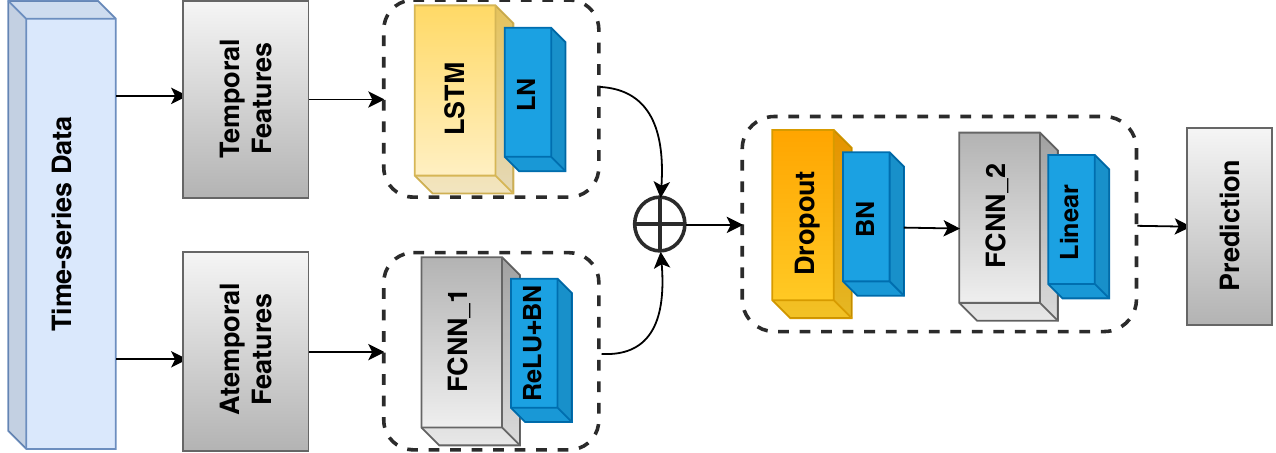
Figure 14. The LSTM recurrent neural network model